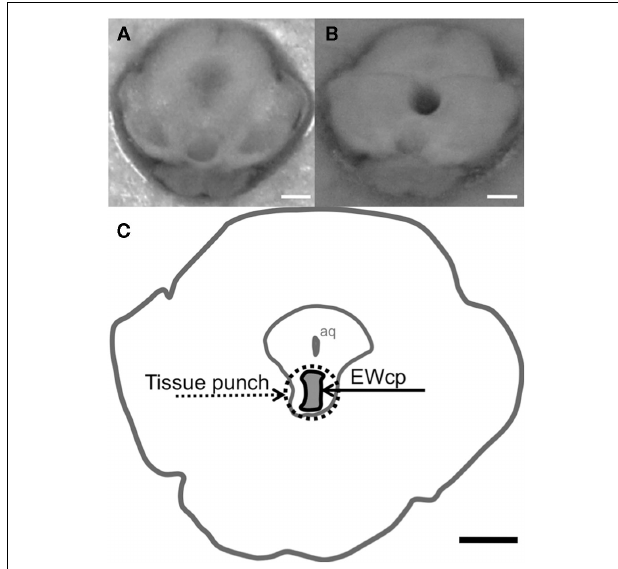
FIGURE 1 |Tissue punch microdissection of the centrally-projecting neurons of the Edinger–Westphal nucleus. (A) Photograph demonstrating a 1-mm-thick coronal slice of the adult B6 mouse midbrain fresh after dissection, in which the EWcp is still intact and (B) photograph demonstrating a frozen slice of the midbrain in which the EWcp has been punched out with an 18-gage blunt needle and removed by making a horizontal cut with a razor blade just dorsal to the EWcp and sliding the tissue sample along the metal plate for harvesting. (C) Schematic of the location of the EWcp within a coronal slice of the midbrain (approx. − 3.5mm from bregma), indicating the area dissected by the tissue punch micropunch. Each scalebar =